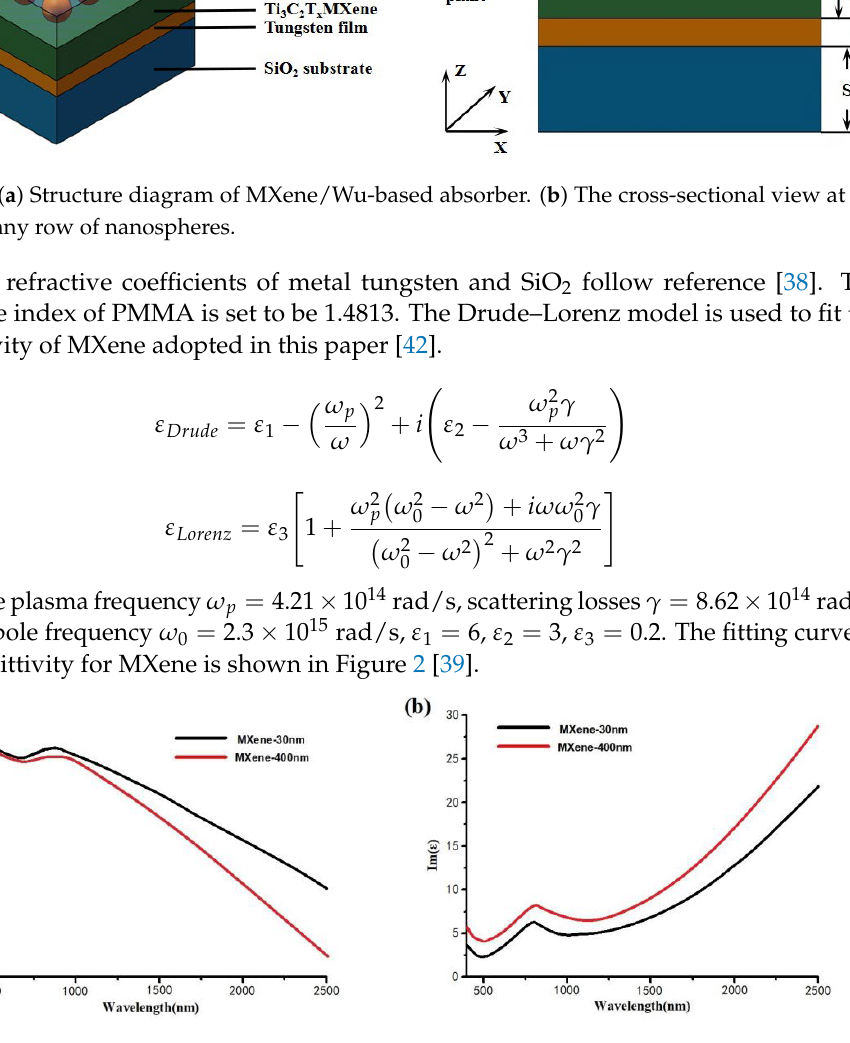
Figure 2. The fitting curve of the permittivity for MXene: (a) the real part; (b) the imaginary part.